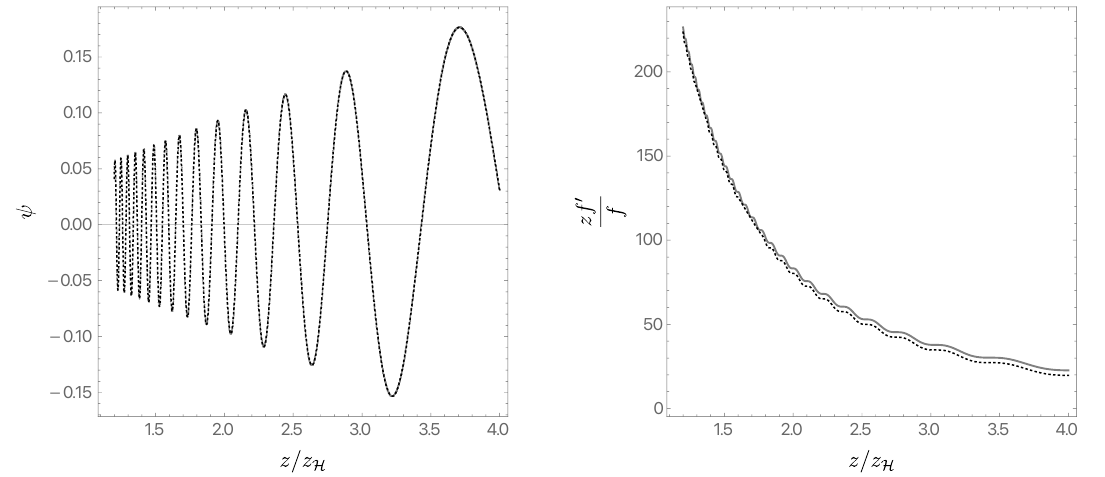
Figure 2 . A comparison of the numerical solutions (solid grey lines) and fits to the analytic expressions (4.9) and (4.12) (black dotted curves) describing Josephson oscillations. This is for mM = 0 . 941632 , Q/Q c = 1 . 001833 , q = m and α = 1